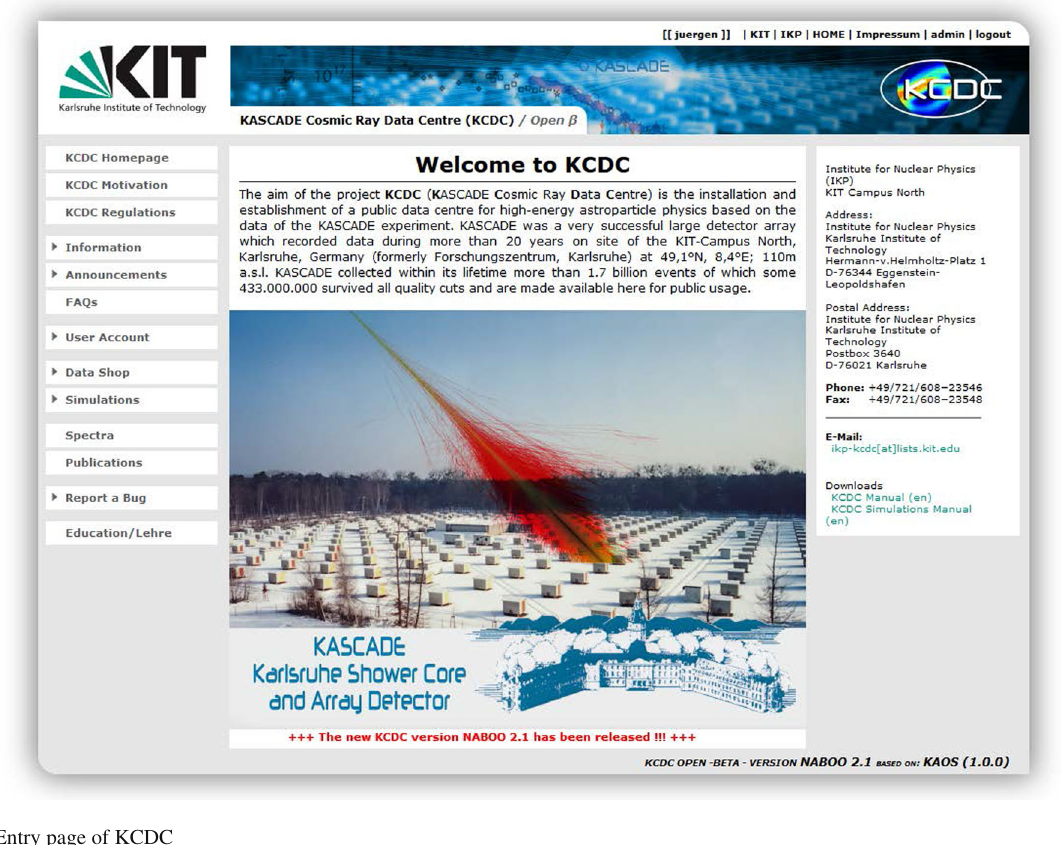
Fig. 11 Entry page of KCDC